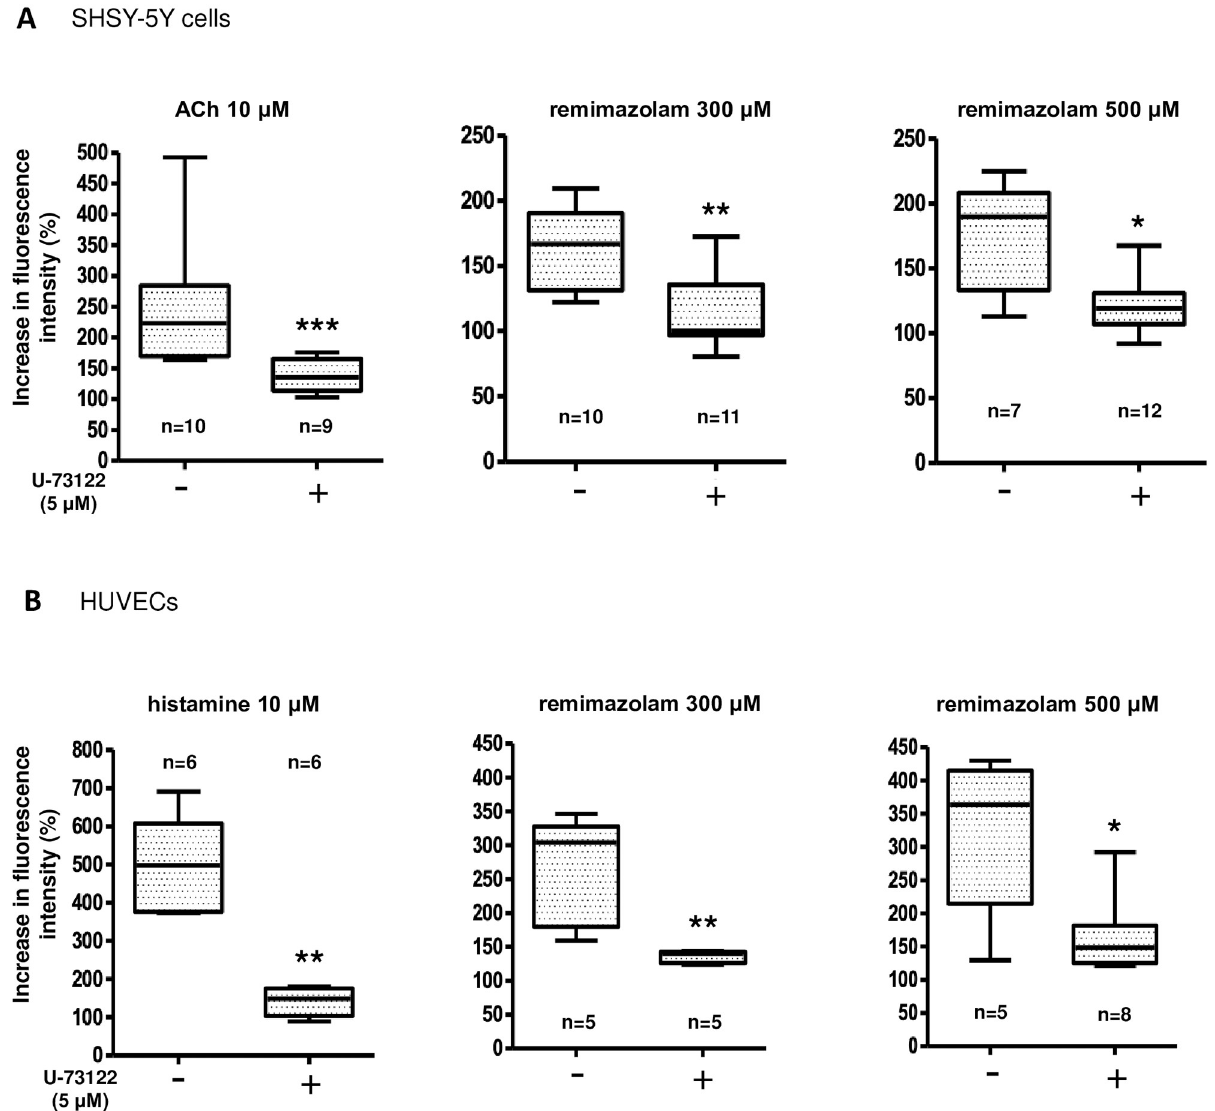
Fig 6. Characterization of remimazolam-induced calcium elevation; possible involvement of the G-protein coupled receptors. (A) Fifteen minutes-pretreatment with U-73122, a phospholipase C (PLC) inhibitor, at 5 μ M significantly inhibited the 10 μ M acetylcholine (ACh)-induced calcium elevation in SHSY-5Y cells (n = 9–10, ��� p = 0.0004, compared to control, Mann Whitney test). Similarly, 15 minutes-pretreatment with U- 73122 significantly affect 300 and 500 μ M remimazolam-induced calcium elevation in SHSY-5Y cells (n = 9–10, �� p = 0.0044, compared to control, Mann Whitney test, and n = 7–12, � p = 0.018, compared to control, Mann Whitney test, respectively). The horizontal line in each box indicates the median, the box shows the interquartile range (IQR), and the whiskers represent 1.5 × IQR. (B) Fifteen minutes-pretreatment with U-73122 at 5 μ M significantly inhibited the 10 μ M histamine-induced calcium elevation in HUVECs (n = 6, �� p = 0.0022, compared to control, Mann Whitney test). Similarly, 15 minutes-pretreatment with U-73122 significantly affected 300 and 500 μ M remimazolam-induced calcium elevation in HUVECs (n = 5, �� p = 0.0079, compared to control, Mann Whitney test, and n = 5–8, � p = 0.0295, compared to control, Mann Whitney test, respectively). The horizontal line in each box indicates the median, the box shows the interquartile range (IQR), and the whiskers represent 1.5 ×